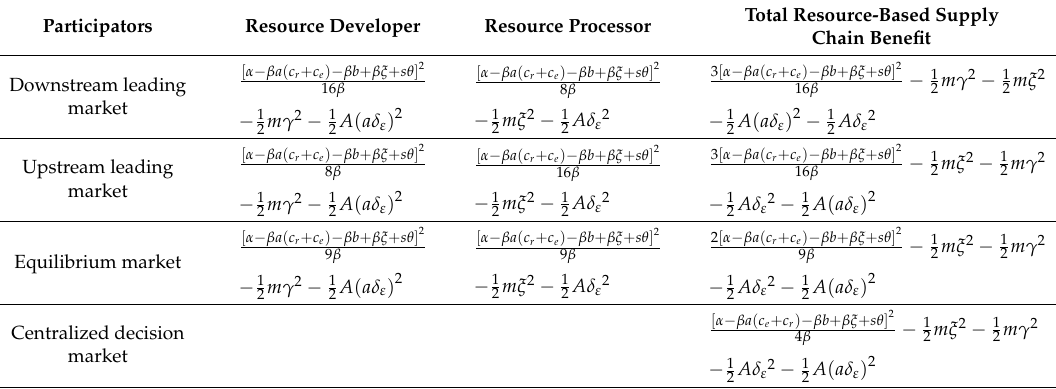
Total Resource-Based Supply Chain Benefit